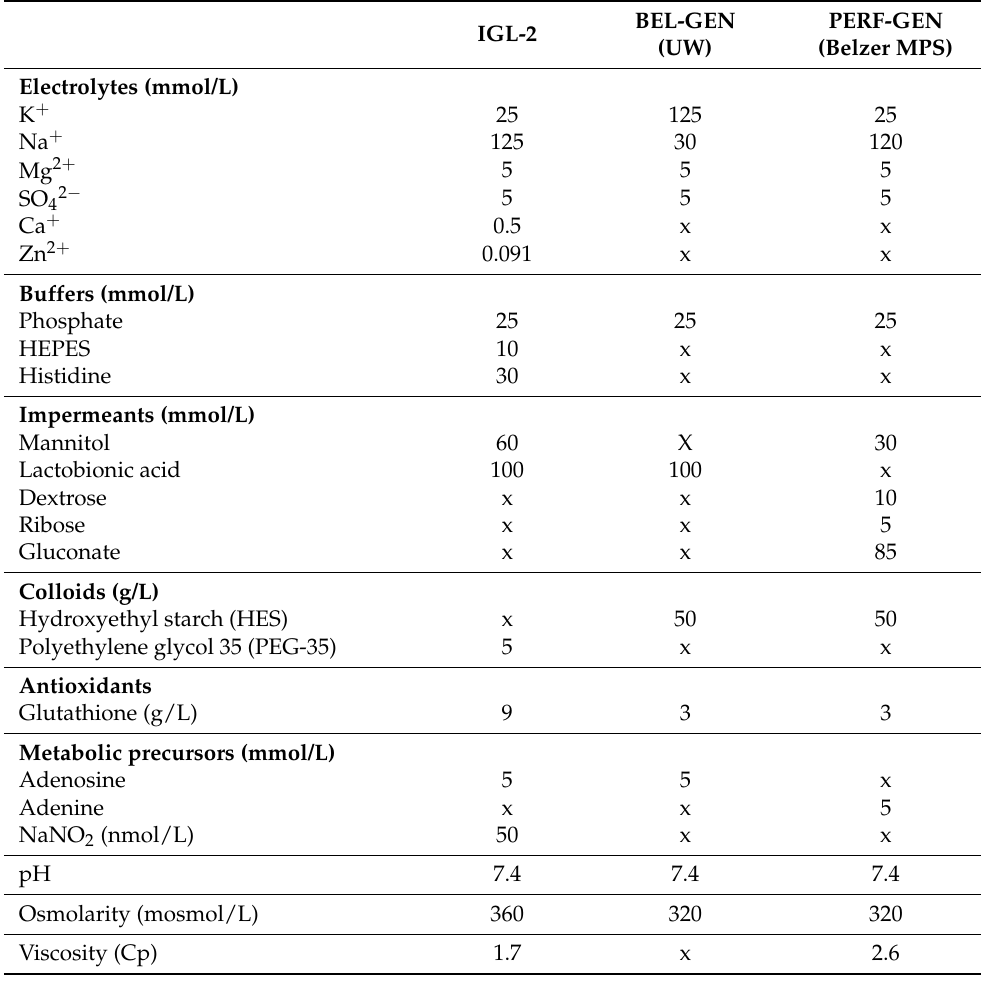
BEL-GEN PERF-GEN IGL-2 (UW) (Belzer MPS)